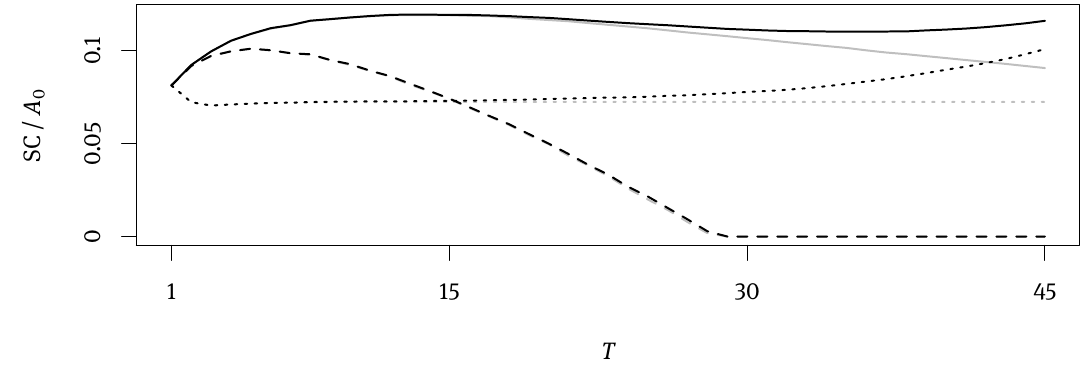
Figure 5: Solvency capital with the complete model in proportion of the initial value of the portfolio: solvency capital under SII (black dotted line), at maturity (black dashed line) and at ruin (black solid line). The corresponding curves without the longevity risk ( σ x = 0 ) are given in